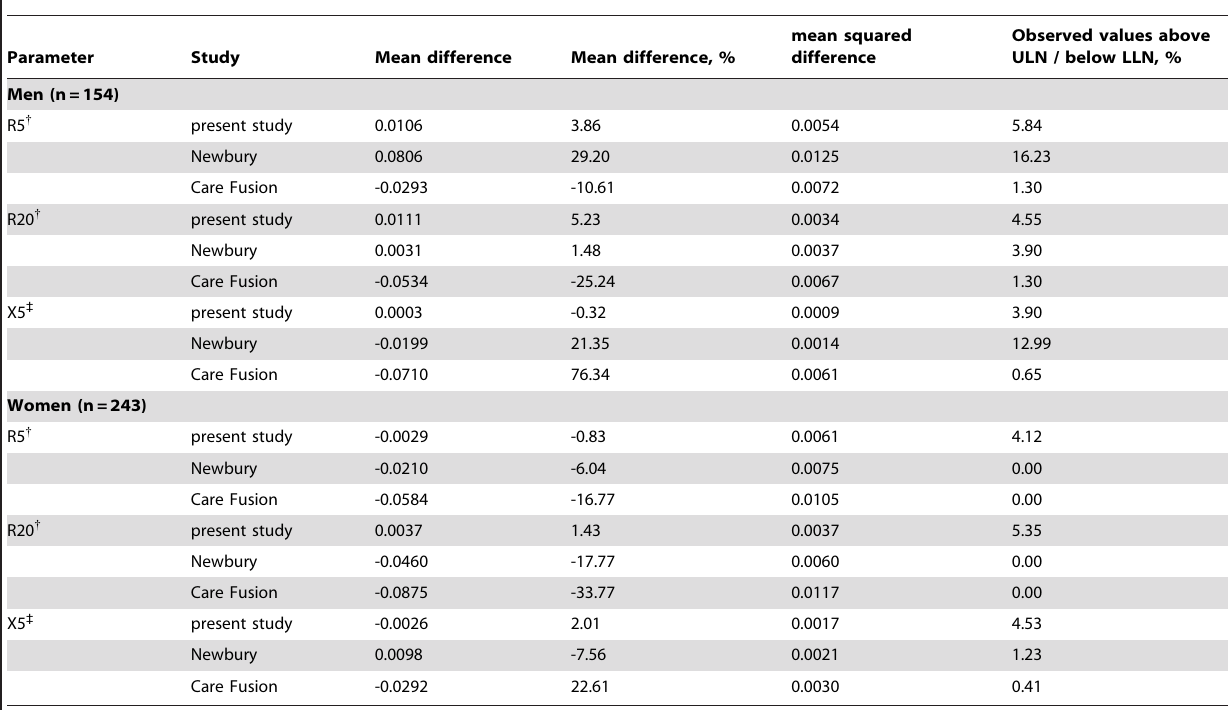
Table 5. Differences between observed values and predictions in lung healthy individuals.